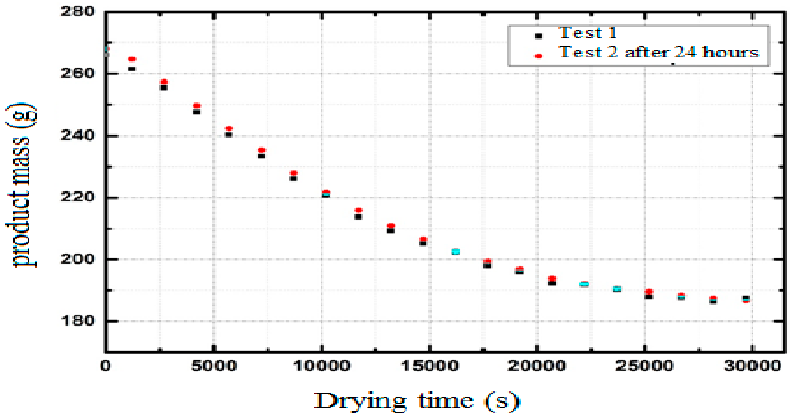
Figure 3. Reproducibility of the curves of the mass of corn during drying, T = 70 °C, V = 1 m·s − 1 , RH = 5 %, and h = 5 cm.